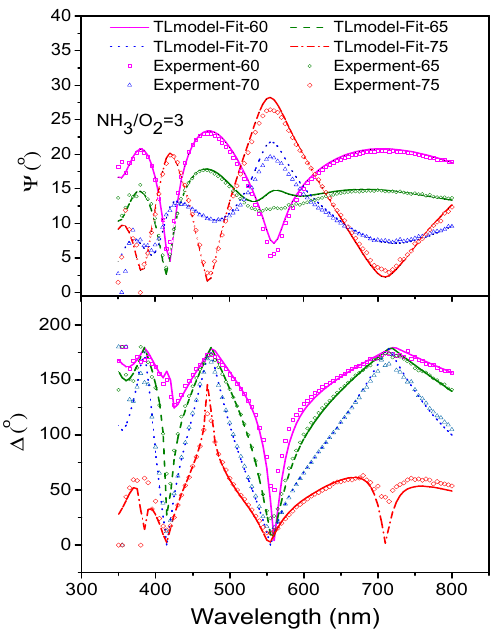
Figure 2. A fitting example of the TiON-3 film expressed by Ψ and ∆ with a root mean square (RMS) of 4.8.